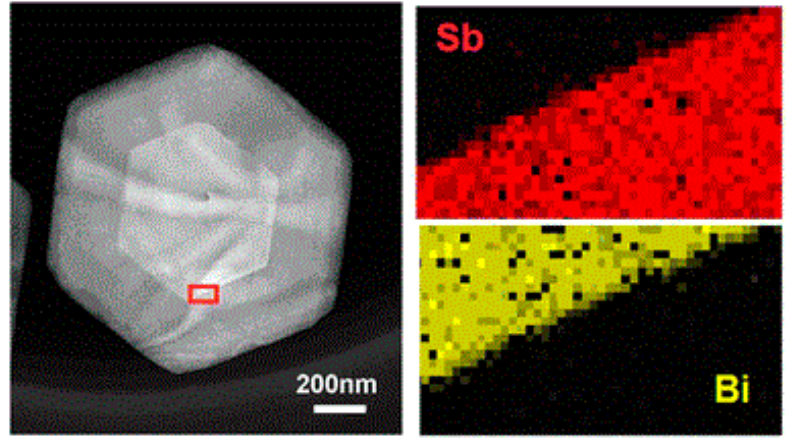
Figure 4. TEM image of lateral heterojunction and junction of Bi and Sb [72].